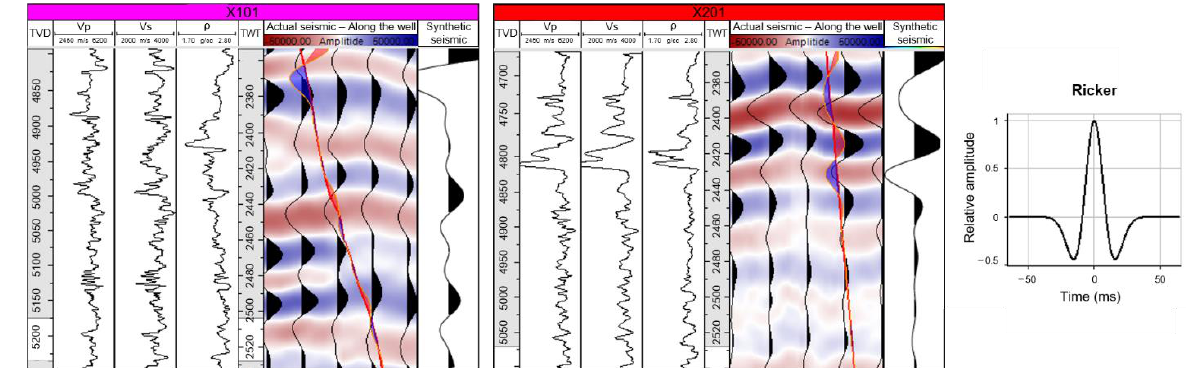
Figure 14. The synthetic and observed seismic traces.